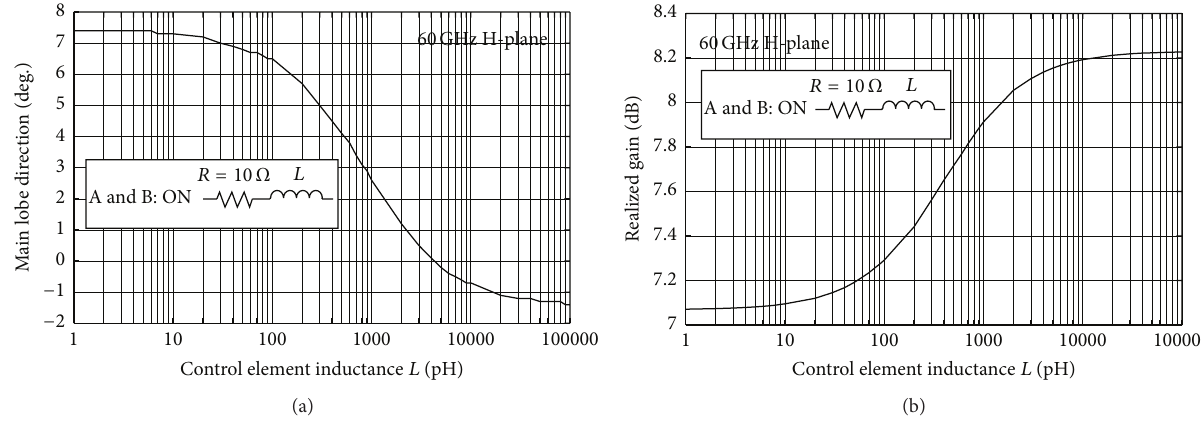
Figure 11: H-plane radiation pattern main beam direction (a) and realized gain (b) at 60 GHz for the reconfigurable antenna with A and B control elements in “ON”